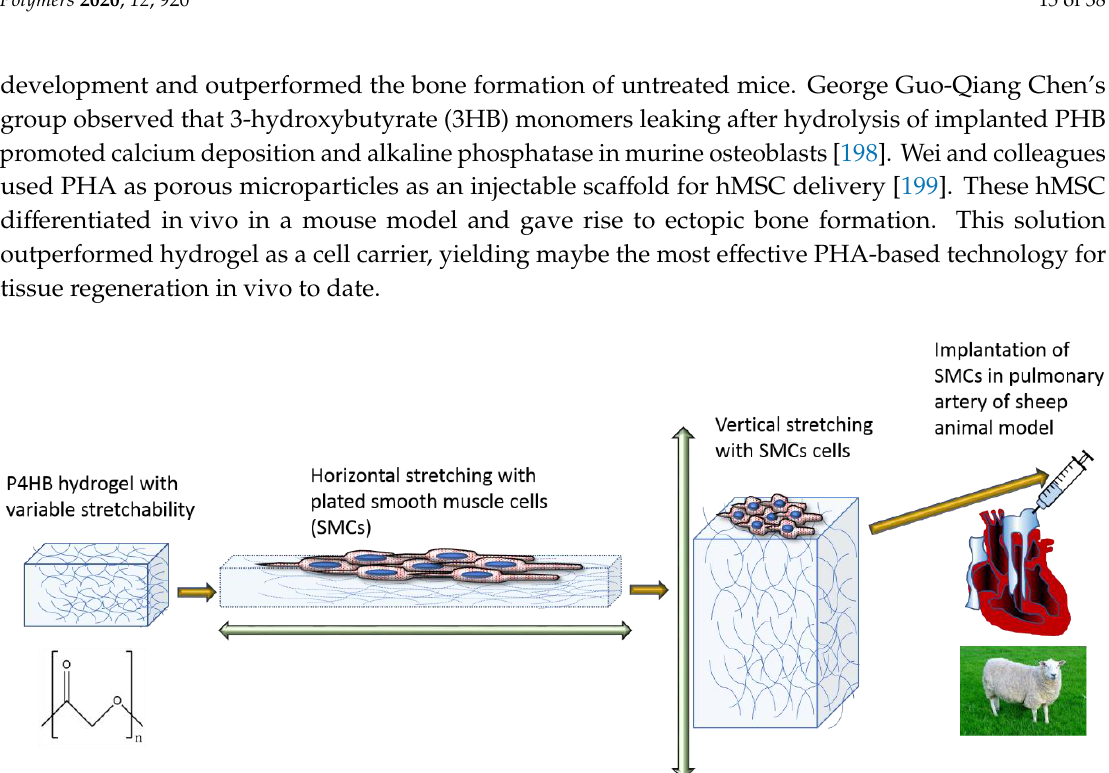
Figure 4. Poly-4-hydroxybutyrate-based hydrogel as an anelastomeric scaffold for a cyclic stretchability for the improved plating of smooth muscle cells (SMCs). These cells were implanted on a pulmonary artery of an animal model (sheep) after the growth on the scaffold in vitro. Freely adapted from Masoumi et al. 2017 [194].